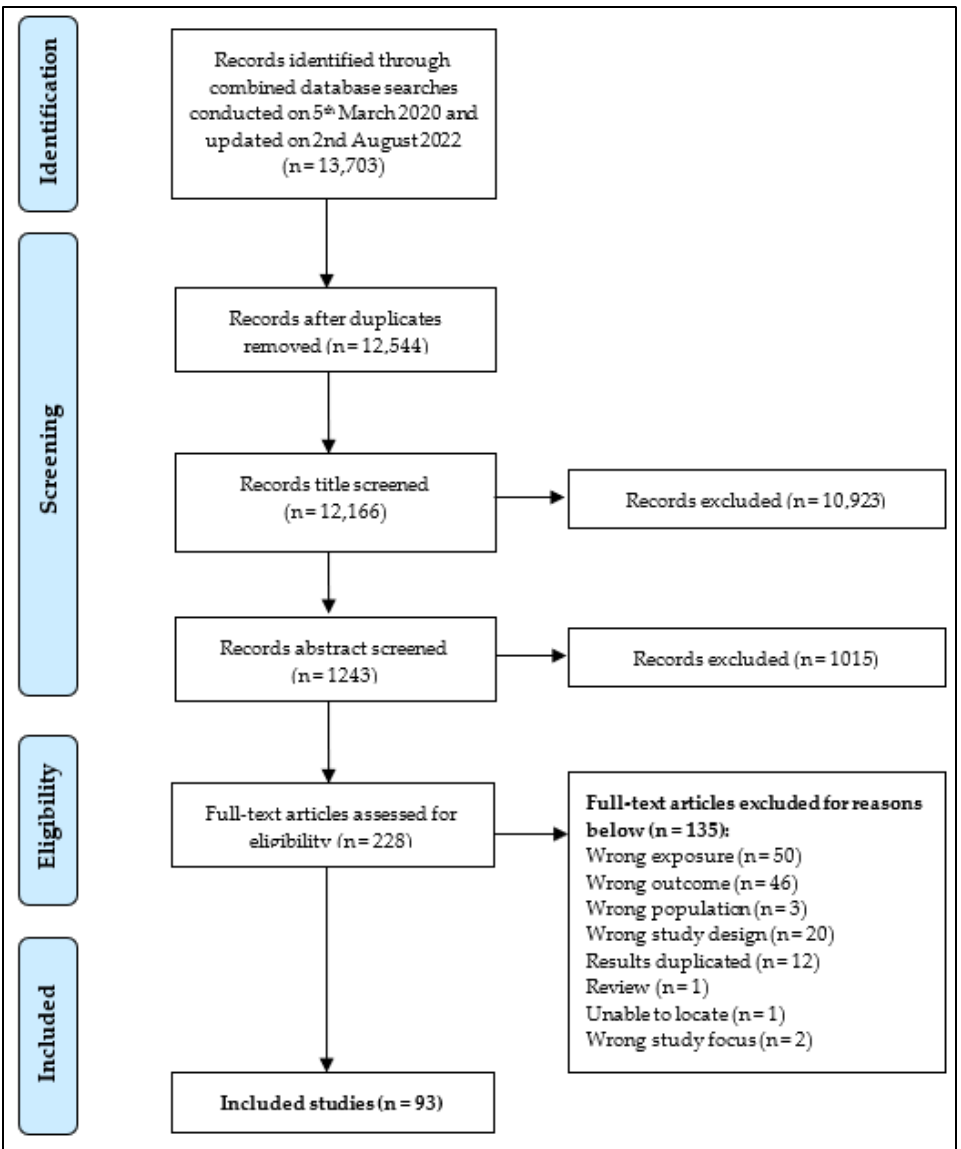
Figure 1. Preferred reporting items for systematic reviews and meta-analyses (PRISMA) flow diagram showing the selection process for studies included in review.